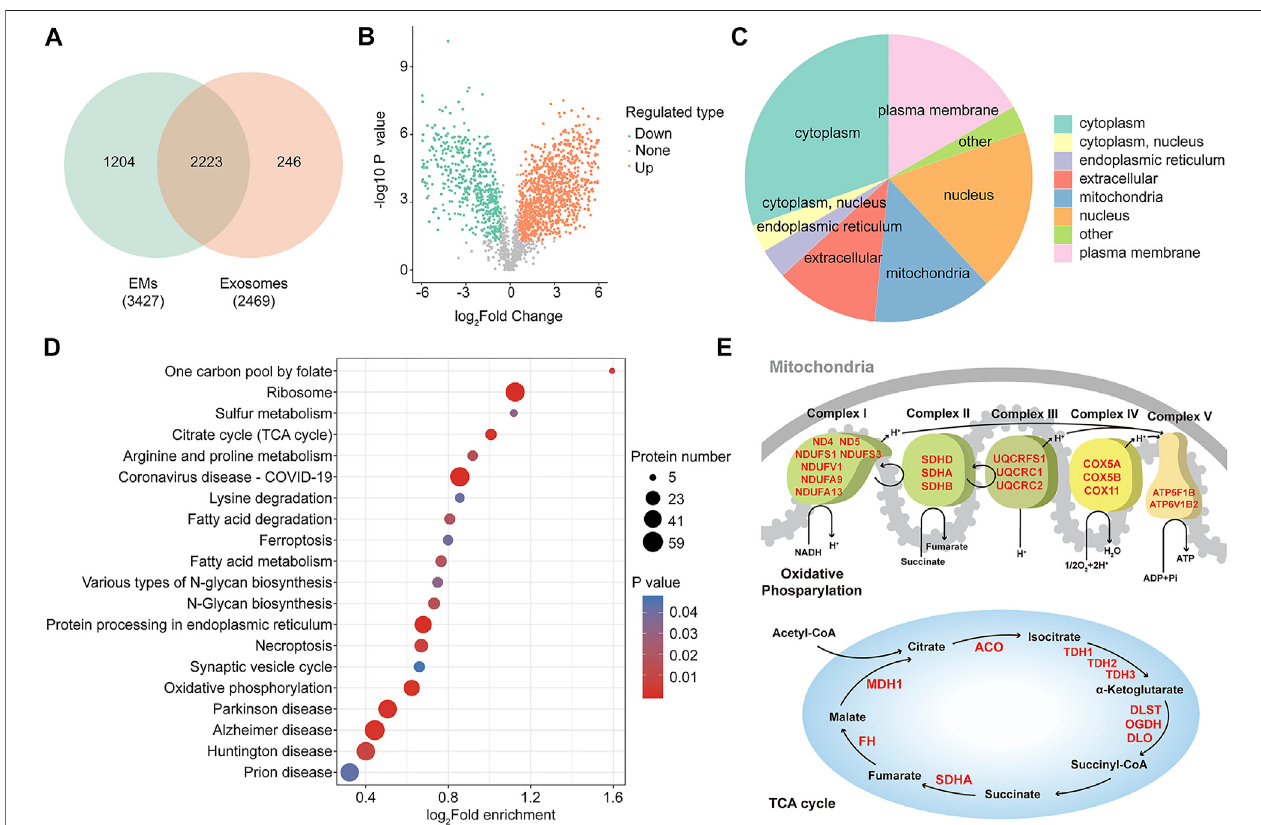
FIGURE 4 | Proteomic pro fi ling reveals a distinct protein landscape between EMs and exosomes. (A) Venn diagram showing the number of identi fi ed proteins of hUMSC-derived exosomes and EMs ( n = 3). (B) Volcano plots are useful to visualize differentially enriched protein patterns among hUMSC-derived EMs and exosomes (the quantitative difference in enriched protein between EMs to exosomes using p -value > 0.05, FC ≥ 1.5). (C) Subcellular analysis of differentially enriched protein annotations between EMs and exosomes. (D) KEGG enrichment analysis of differentially enriched proteins annotations between EMs and exosomes. (E) Upregulated protein enriched in mitochondrial oxidative phosphorylation and the TCA